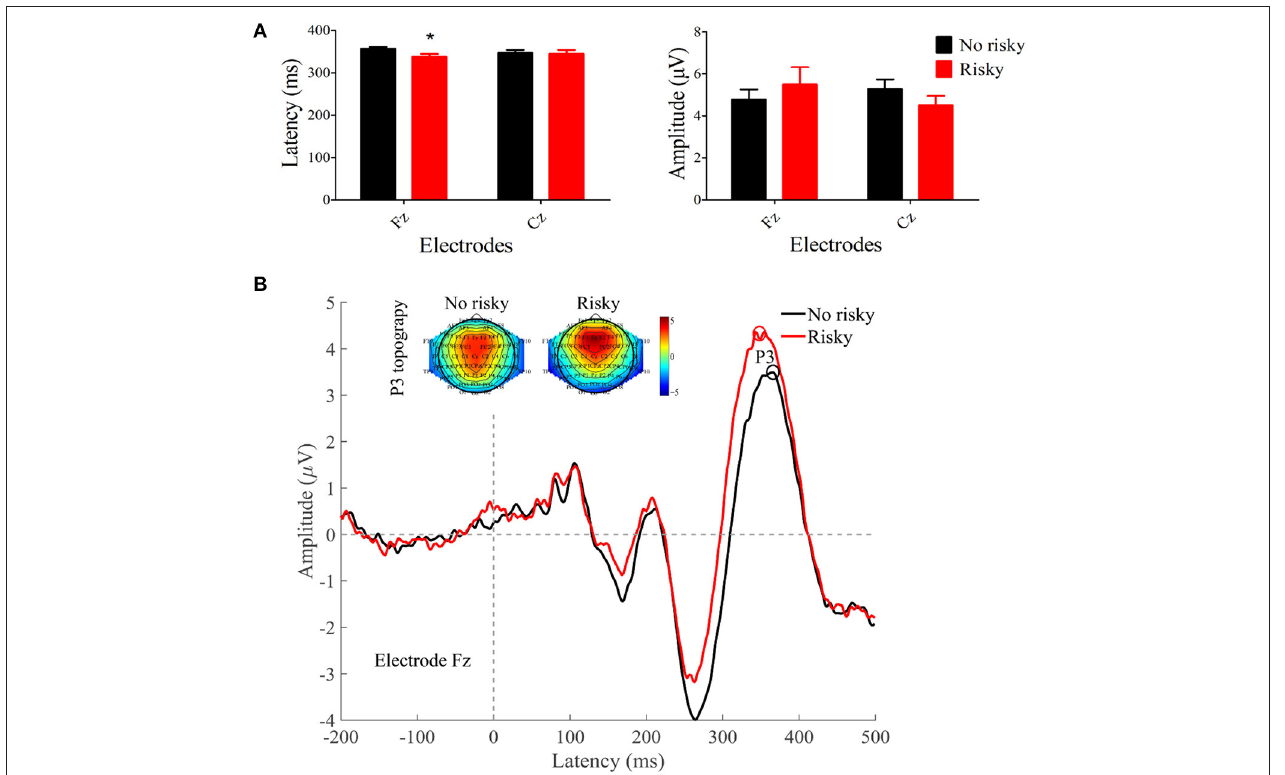
FIGURE 1 | Comparison of P300 latency and amplitude between OPAD with and without risky drinking respectively. (A) Comparison of P300 latency and amplitude between two groups on electrodes of Fz and Cz; (B) Grand-averaged ERP waveforms in response to target stimuli in the first halves and the second halves as a function of group. Topographic maps of the P300 (235–400ms) are shown. * P <